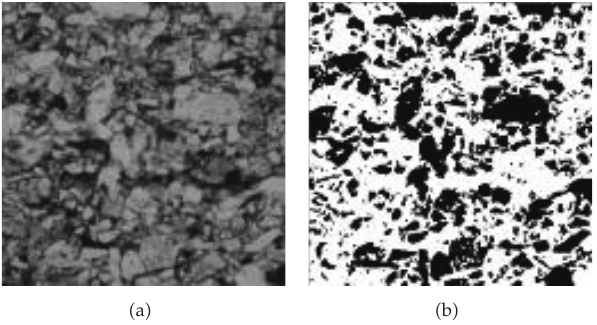
Figure 1: (cid:2) a (cid:3) The grayscale sandstone image obtained by SEM. (cid:2) b (cid:3) The binary pore image (cid:2) black and white colors represent grains and pore spaces, resp. (cid:3) .